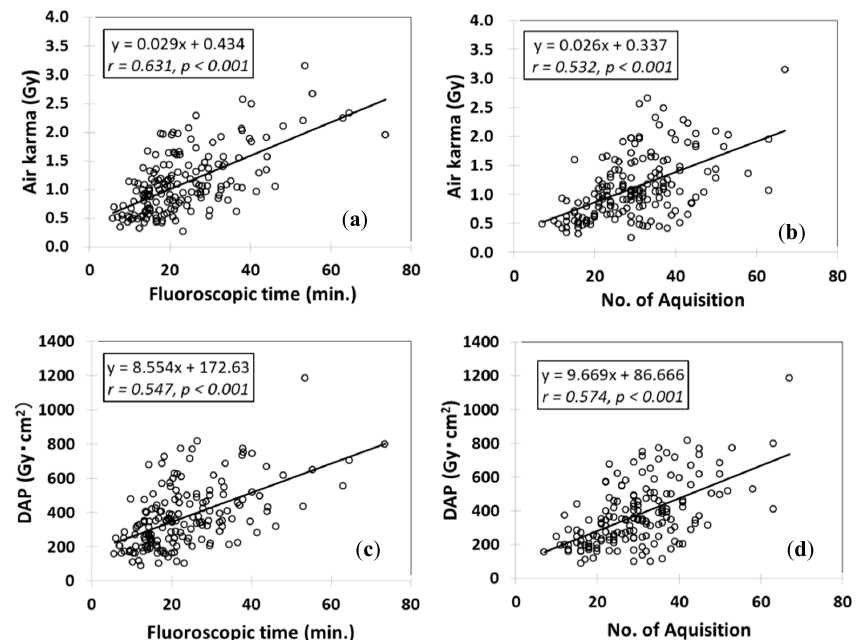
the number of acquisitions (DA and DSA). ( c ) The relationship between DAP and FT. ( d ) The relationship between DAP and the number of acquisition (DA and DSA).